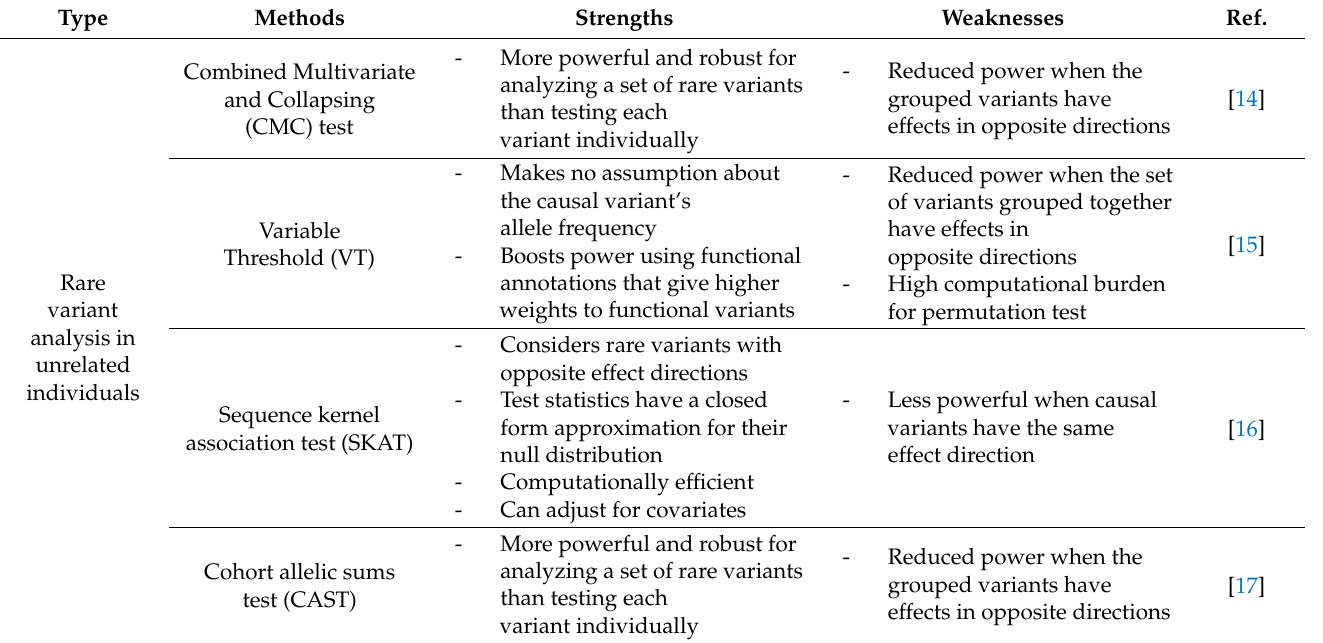
Table 1. Statistical approaches for population-based or family-based rare variant